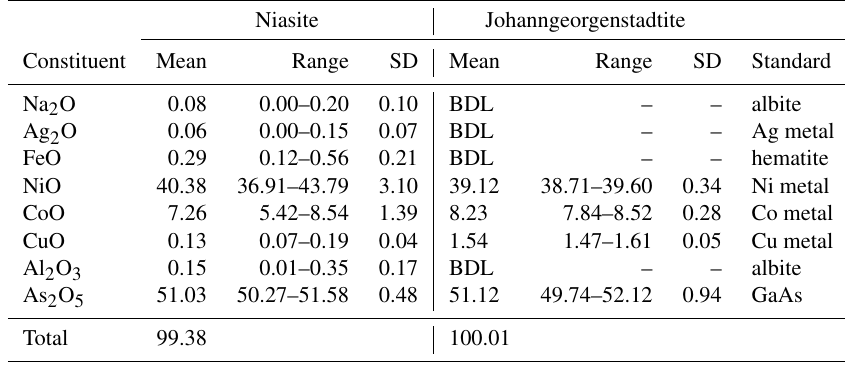
Table 1. Analytical data (wt%) for niasite and johanngeorgenstadtite. Niasite Johanngeorgenstadtite Constituent Mean Range